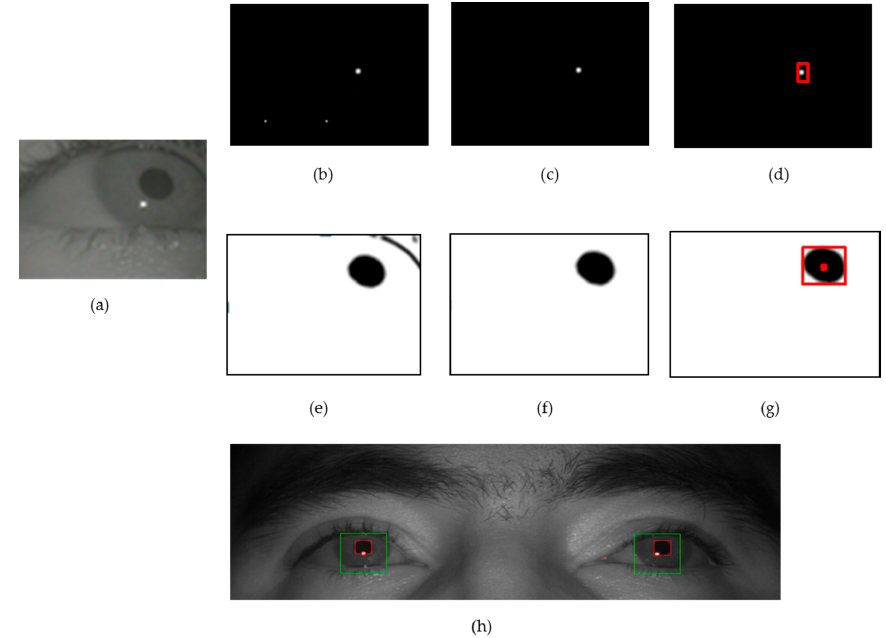
Figure 7. The glint and pupil center region detection process: ( a ) Eye region extracted from original image; ( b ) Binarization of gray level image for glint; ( c ) Application of morphological filter to the glint; ( d ) Weighted average technique applied to the glint; ( e ) Application of binarization to the pupil image; ( f ) Application of morphological filter to the pupil; ( g ) Application of weighted average technique to the pupil; ( h ) Pupil and glint detection of two eyes in the face image.